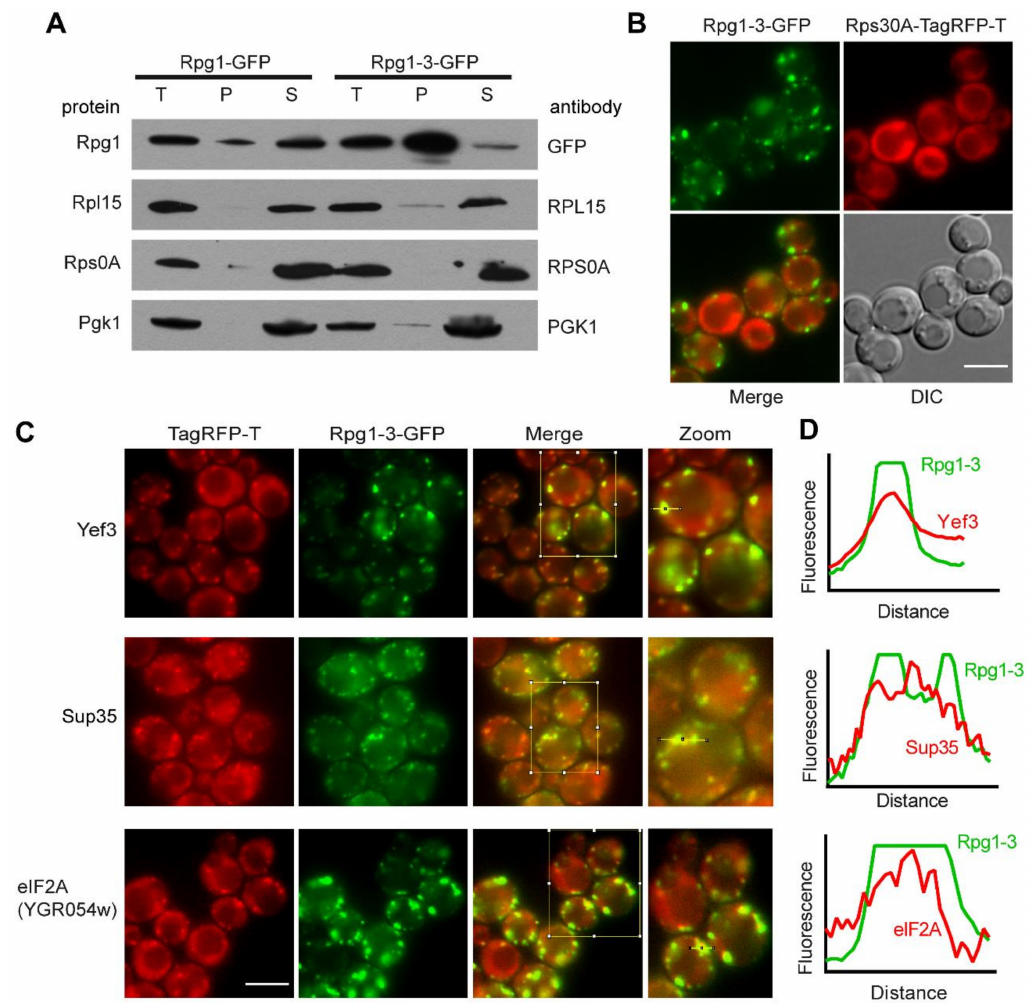
Figure 3. Rpg1-3 foci formed at 42 ◦ C contain translation machinery components but not ribosomes. ( A ) Western blotting of samples from differential centrifugation of Rpg1-3-GFP producing cells after HS 42 ◦ C 30 min. Pgk1 was included as a non-aggregating control. (T)—total protein lysate before centrifugation, 2% v / v ; pellet (P) and supernatant (S) fractions, 20% v / v of the volume of input protein lysates. Exponentially growing cells carrying Rpg1-3-GFP were heat-shocked at 42 ◦ C for 30 min, and colocalization of Rpg1-3-GFP foci with ( B ) Rps30-TagRFP-T ( C ) Yef3, Sup35, or eIF2A/YGR054w was followed by live-cell imaging. Scale bars, 5 µ m. ( D ) Plot profiles of the fluorescence intensity along the yellow line in the zoomed images in ( C